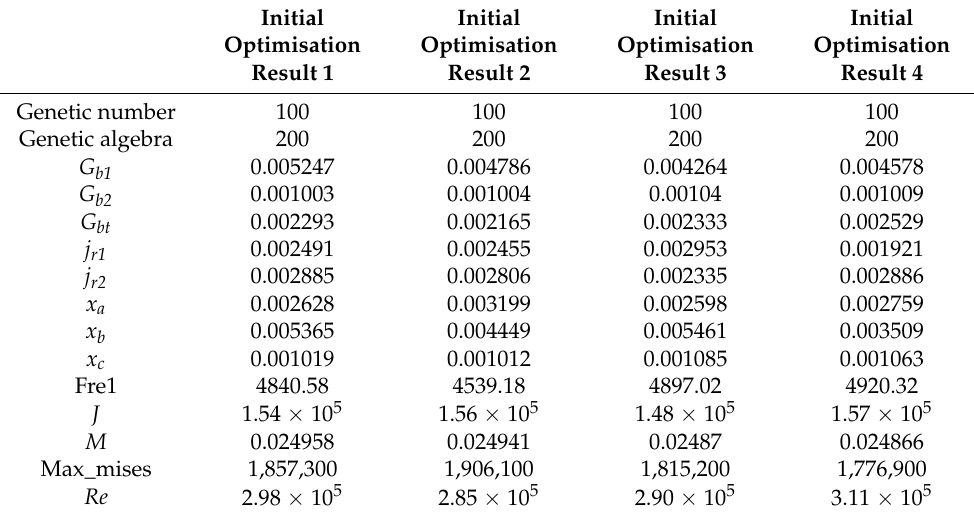
Table 3. Initial optimisation results.